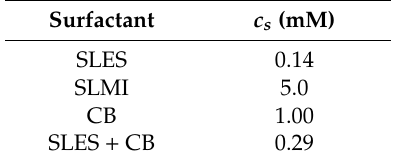
Table 1. Critical micellar concentration values obtained from surface tension